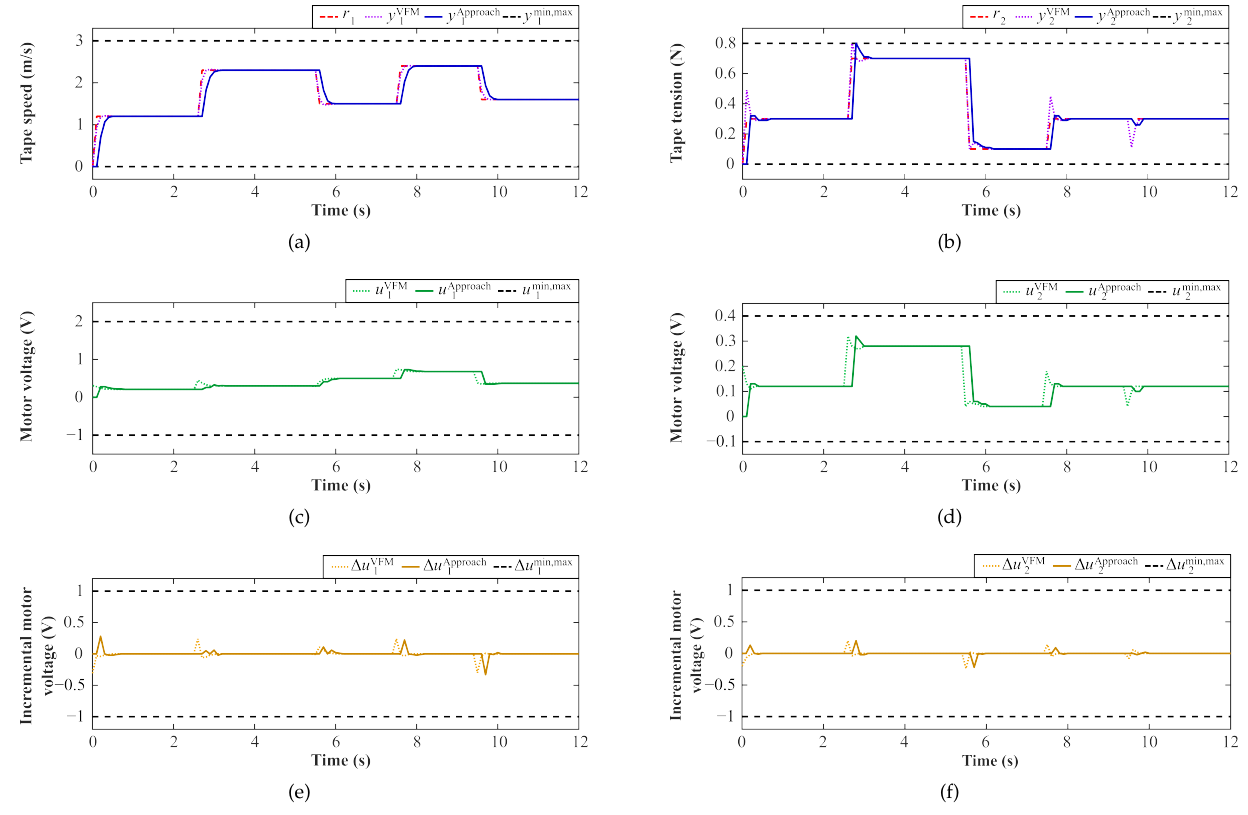
Figure 9. Results for the tape transport system under VFM and Approach: ( a ) Tape speed. ( b ) Tape tension. ( c ) Motor voltage supply reel. ( d ) Motor voltage take-up reel. ( e ) Incremental motor voltage supply reel. ( f ) Incremental motor voltage take-up reel.